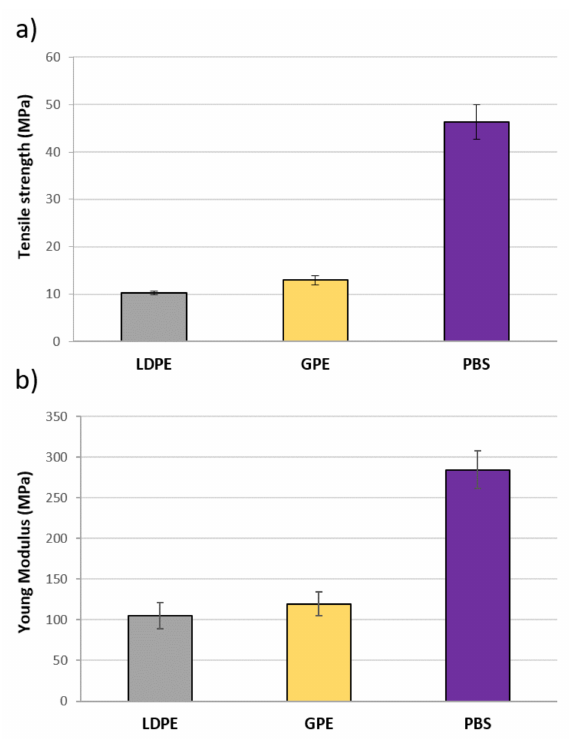
Figure 4. Mechanical properties of matrices. ( a ) Tensile strength and ( b ) Young’s